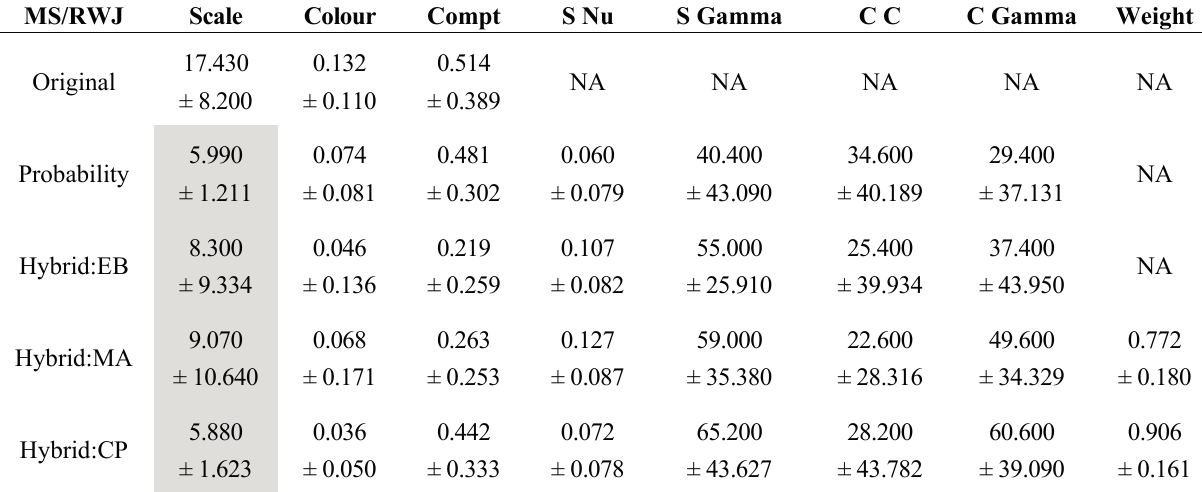
Table 7. Parameters generated for the Hagadera problem